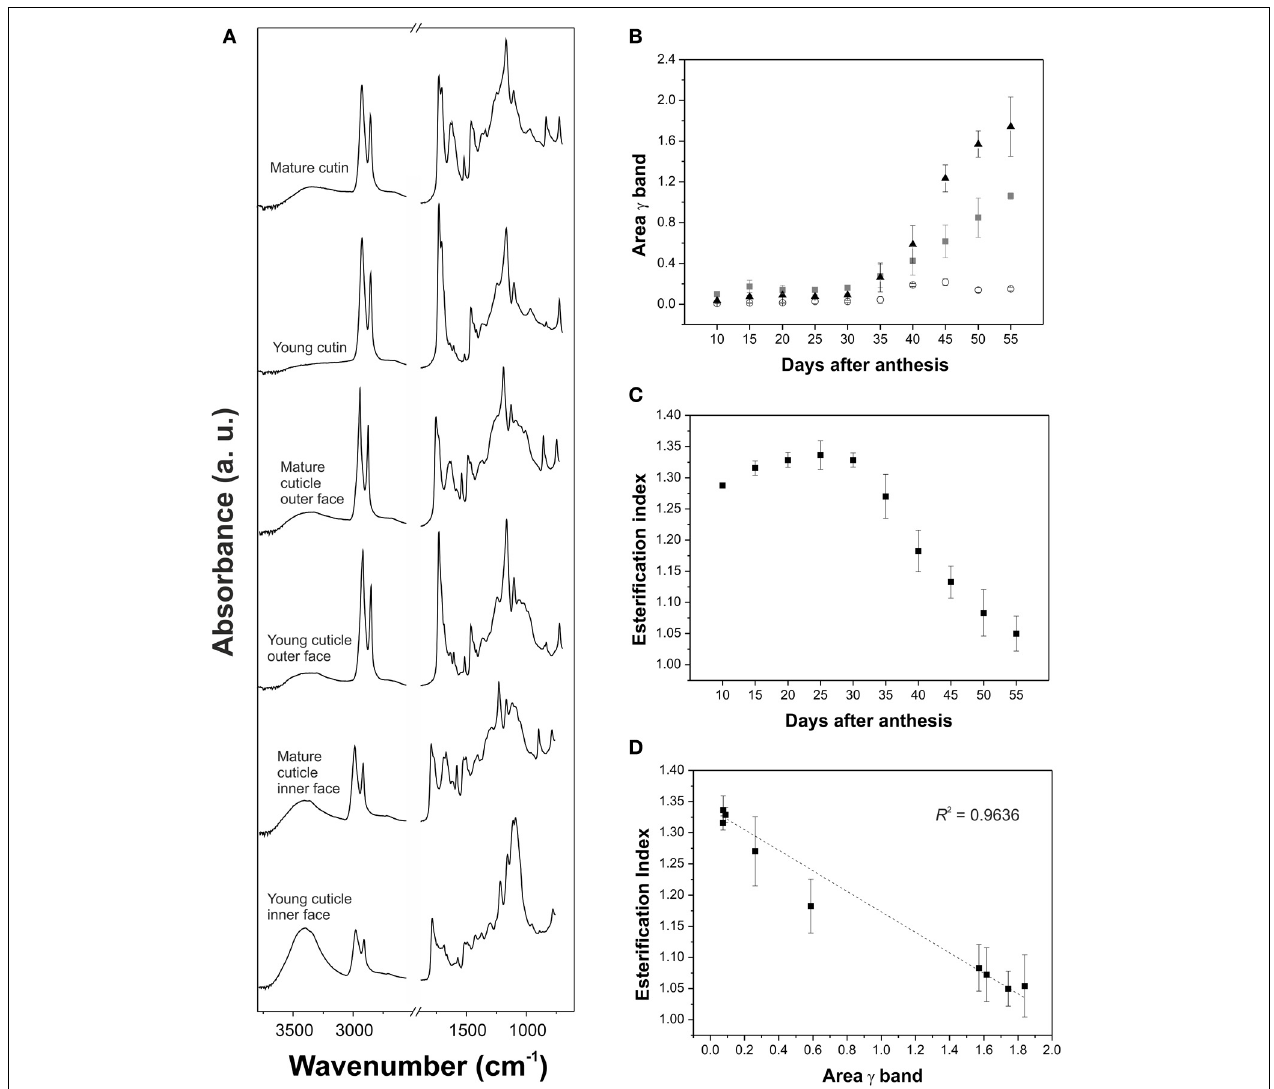
FIGURE 5 | (A) ATR-FTIR spectra in the 3800-600cm − 1 region of young (15 daa) and mature (55 daa) cutin, cuticle outer face and cuticle inner face of tomato fruit. (B) Area of the γ (C-H) aromatic band associated with the presence of phenolic compounds in tomato fruit cuticle during development. Triangles: cutin; squares: cuticle outer surface; circles: cuticle inner surface. (C) Cutin esterification index, calculated as the ratio